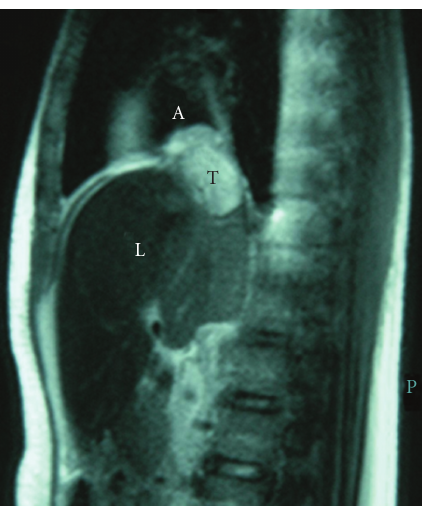
Figure 1: Magnetic resonance scan showing a large tumor mass (T) at the junction of the right atrium (A) and inferior vena cava in association with congested liver (L).